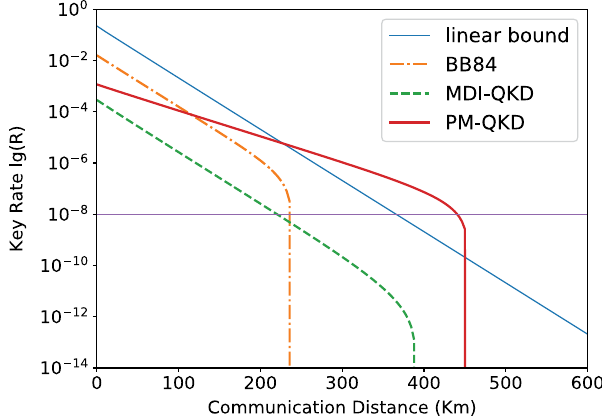
FIG. 3. Simulation of our PM-QKD protocol. For the consid- ered simulation parameters, the key rate of PM-QKD surpasses that of the conventional BB84 protocol when l > 120 km, and it exceeds the linear key-rate bound by Pirandola et al. (PLOB bound) [11] when l > 250 km. In addition, our protocol is also able to achieve a long transmission distance of l ¼ 450 km.